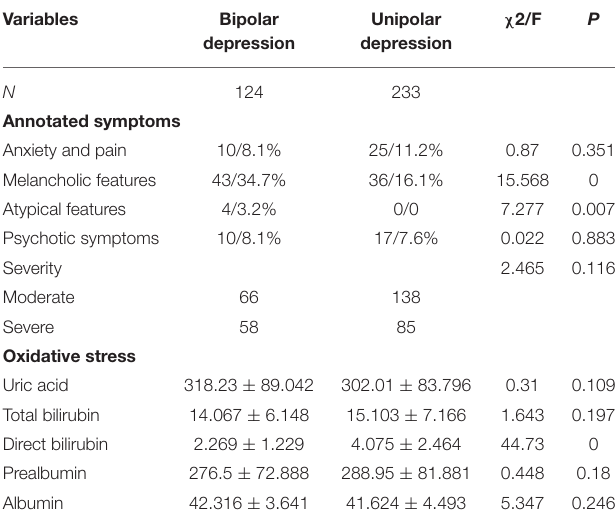
TABLE 2 | Symptoms and oxidative stress related indicators in patients who developed unipolar and bipolar depression in